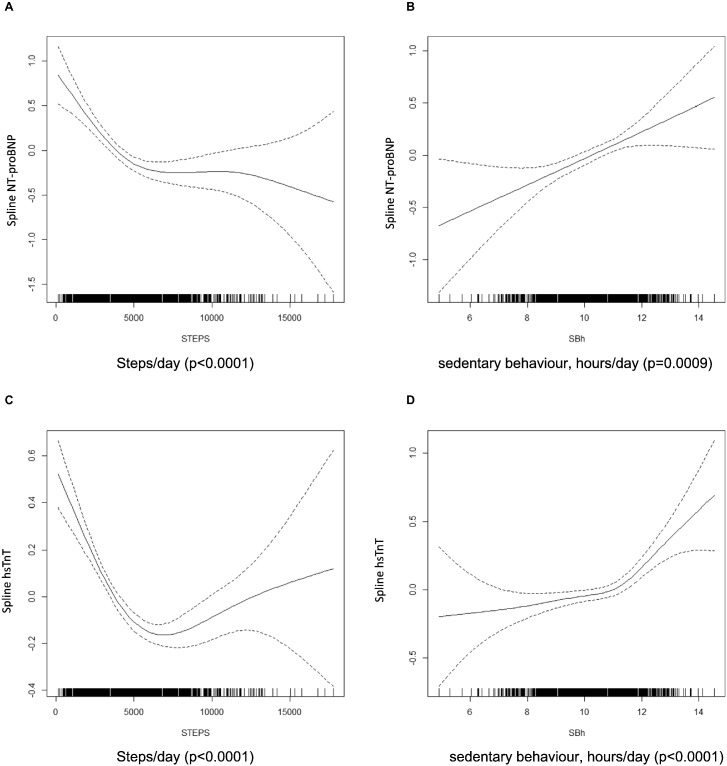
Associations between cardiac biomarkers and physical activity/sedentary behaviour.Relationships between NT-proBNP and steps per day (panel A) and hours per day of sedentary behaviour (panel B) and between hsTnT and steps per day (panel A) and daily hours of sedentary behaviour (panel B). Solid line represents smoothed function from the GAM, with 95% CI (dotted lines), and p values are reported. Each model is adjusted for average daily accelerometer wear time, season of wear, hour of blood sampling, region of residence, age, social class, living alone, tobacco, alcohol consumption.